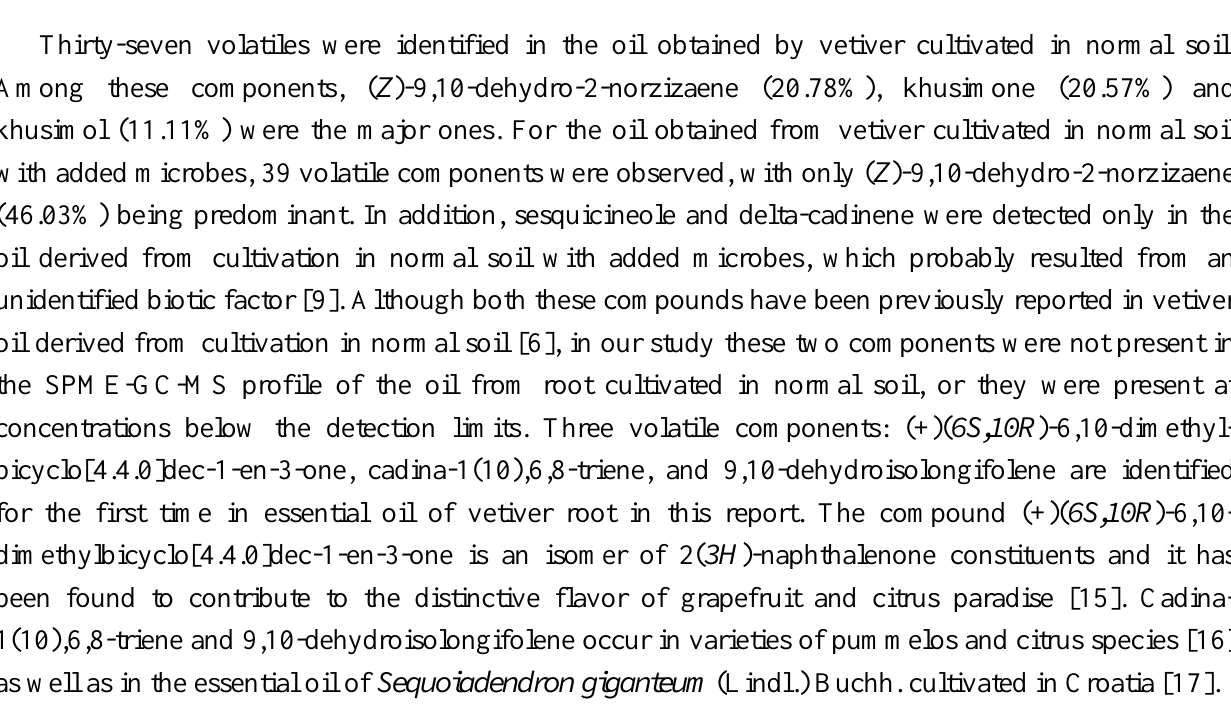
Figure 2. SPME-GC-MS chromatograms of vetiver essential oils obtained from root cultivated in three different systems. A. normal soil B. normal soil with added microbes C. semi-hydroponic